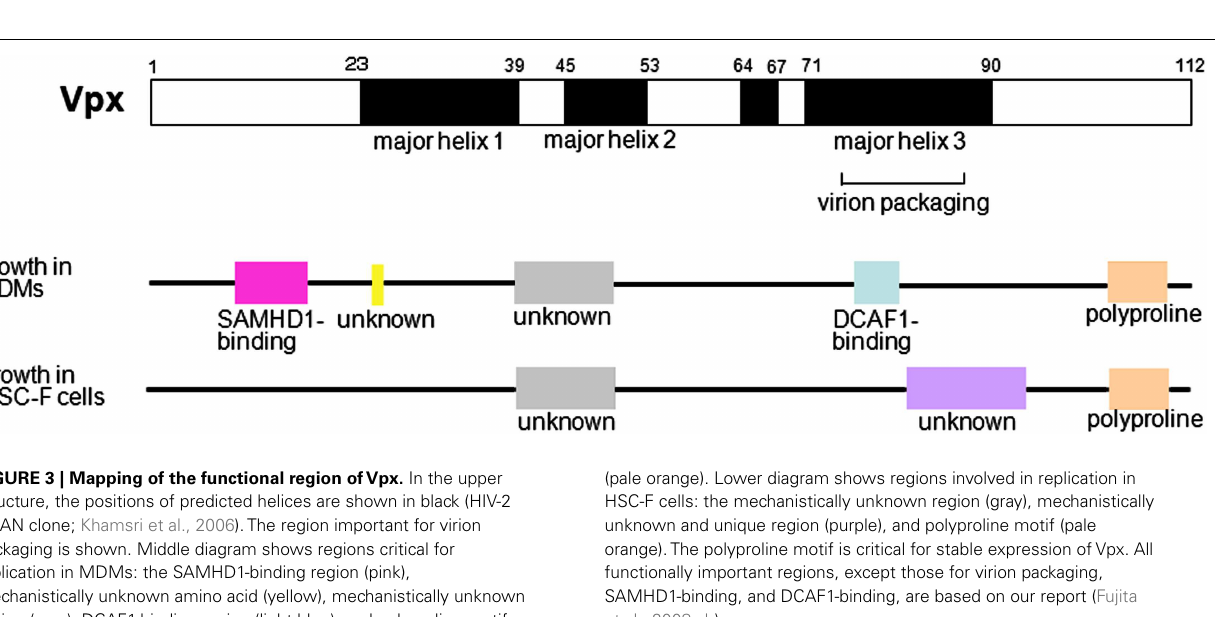
(pale orange). Lower diagram shows regions involved in replication in HSC-F cells: the mechanistically unknown region (gray), mechanistically unknown and unique region (purple), and polyproline motif (pale orange).The polyproline motif is critical for stable expression ofVpx. All functionally important regions, except those for virion packaging, SAMHD1-binding, and DCAF1-binding, are based on our report (Fujita et al.,